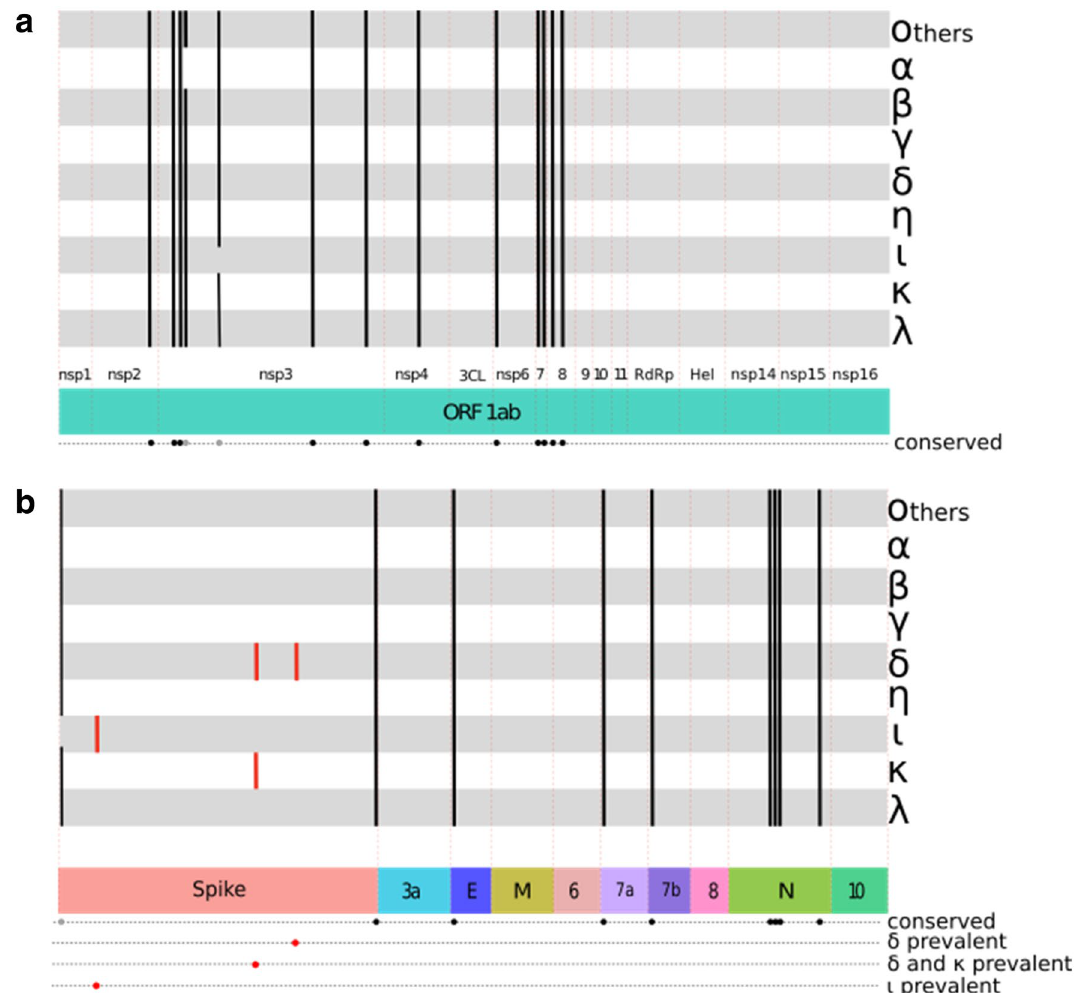
Figure 1. LCRs in VOCs (Alpha, Beta, Gamma and Delta variants), VOIs (Epsilon, Eta, Iota, Kappa and Lambda variants) and Other SARS-CoV-2 proteomes (Others). ( a ) LCRs present in ORF1ab, which includes nsp1-4, 3CL protease (3CL), nsp6-nsp11, RdRp polymerase (RdRp), Helicase (Hel) and nsp 14-16. ( b ) LCRs along spike, ORF3a (3a), envelope (E), membrane (M), ORFs 6, 7a, 7b, 8, nucleocapsid (N) and ORF10. The Spike LCR sequences reported here in the Delta, Iota and Kappa variants are represented with red lines. The width of the lines is not proportional to the number of sequences in each